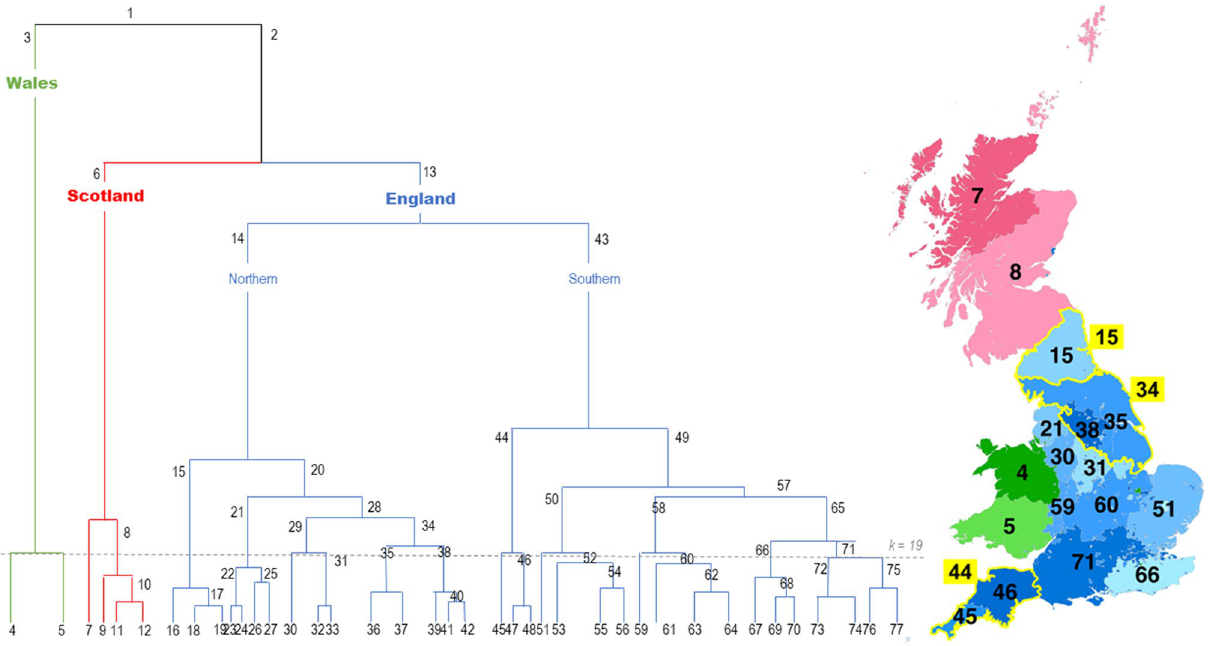
Figure 1. Dendrogram of hierarchical isonymy regions and the spatial extents of k = 19 regions with regions 6, 15, 34 and 44